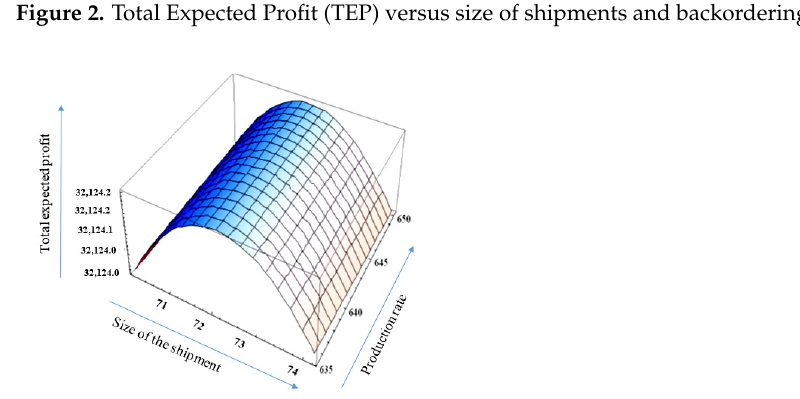
Figure 3. Total Expected Profit (TEP) versus size of shipments and production